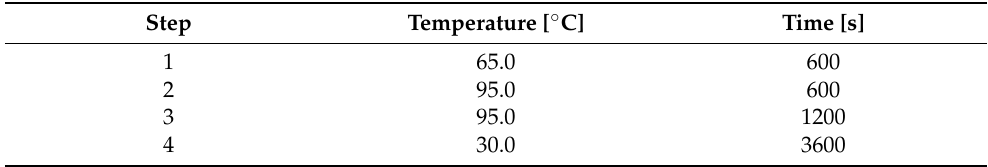
Table 3. Settings for baking before exposure.